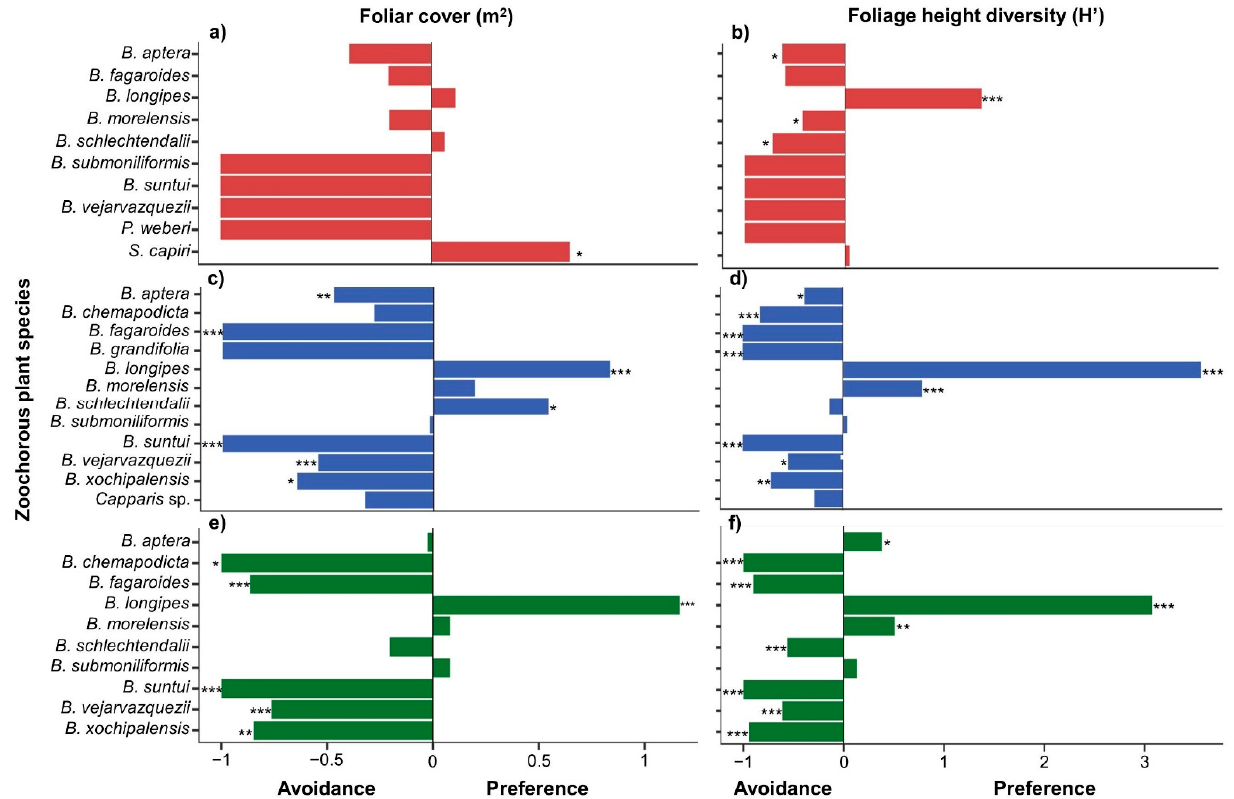
Figure 3. Foraging preferences of fruit-eating birds in a TDF successional gradient in southern Mexico: ( a , b ) early stage, ( c , d ) intermediate stage, and ( e , f ) mature stage. Significant preferences or avoidances are shown with * p ≤ 0.05, ** p ≤ 0.01, *** p ≤ 0.001.